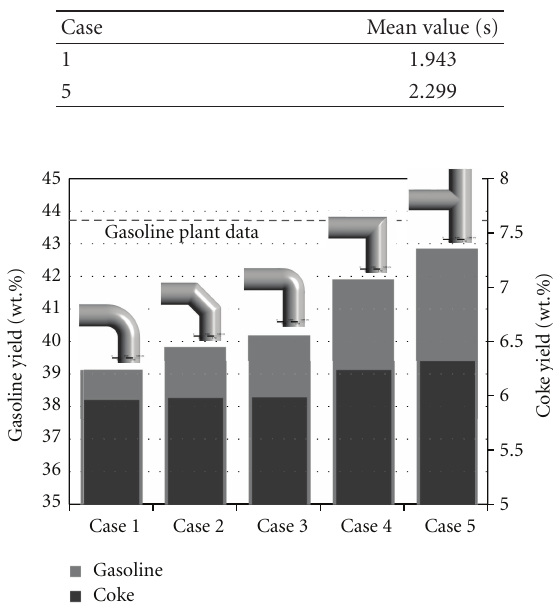
Figure 11: Gasoline and coke yields at the riser outlet.